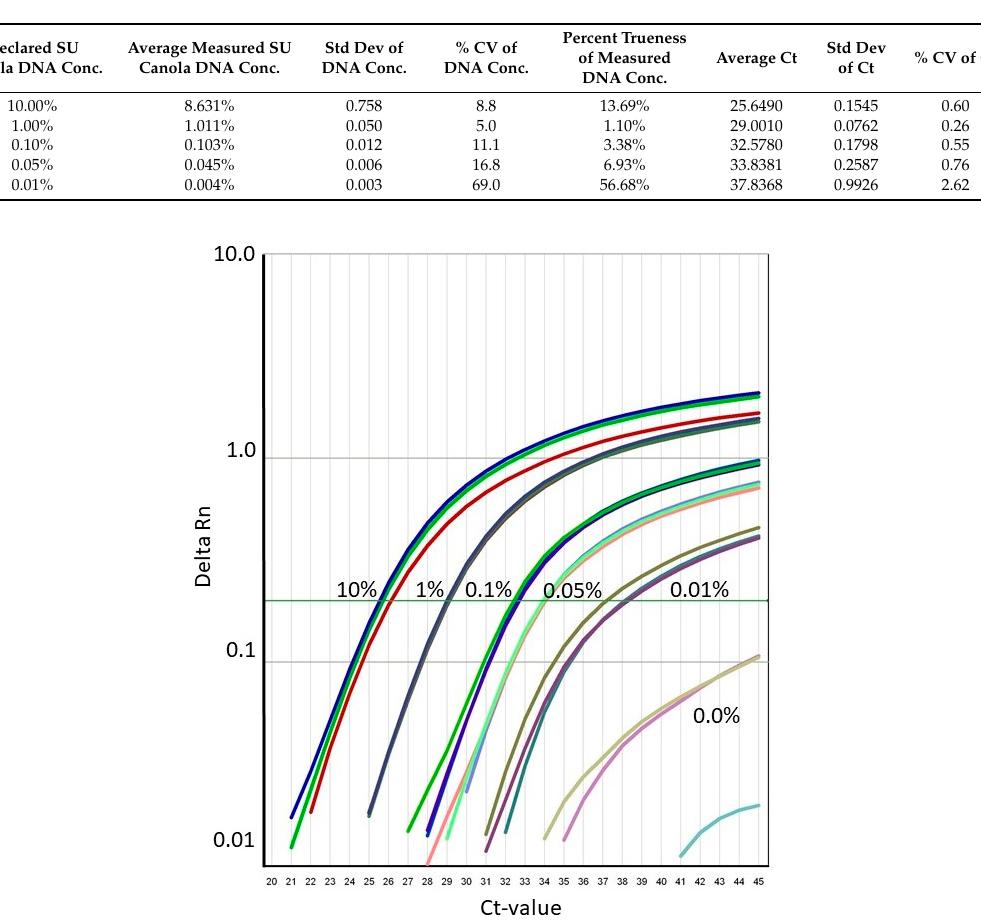
Table4. Real-timequantitativePCRanalysisofSUcanolaDNA,variety40K,mixedatfiveconcentrations with Clearfield canola variety 5545 CL. Total DNA was 300 ng / reaction and n = 12. PCR conditions, as described in Methods using the SU canola-specific primers and probe. % CV indicates % Coe ffi cient of Variation.